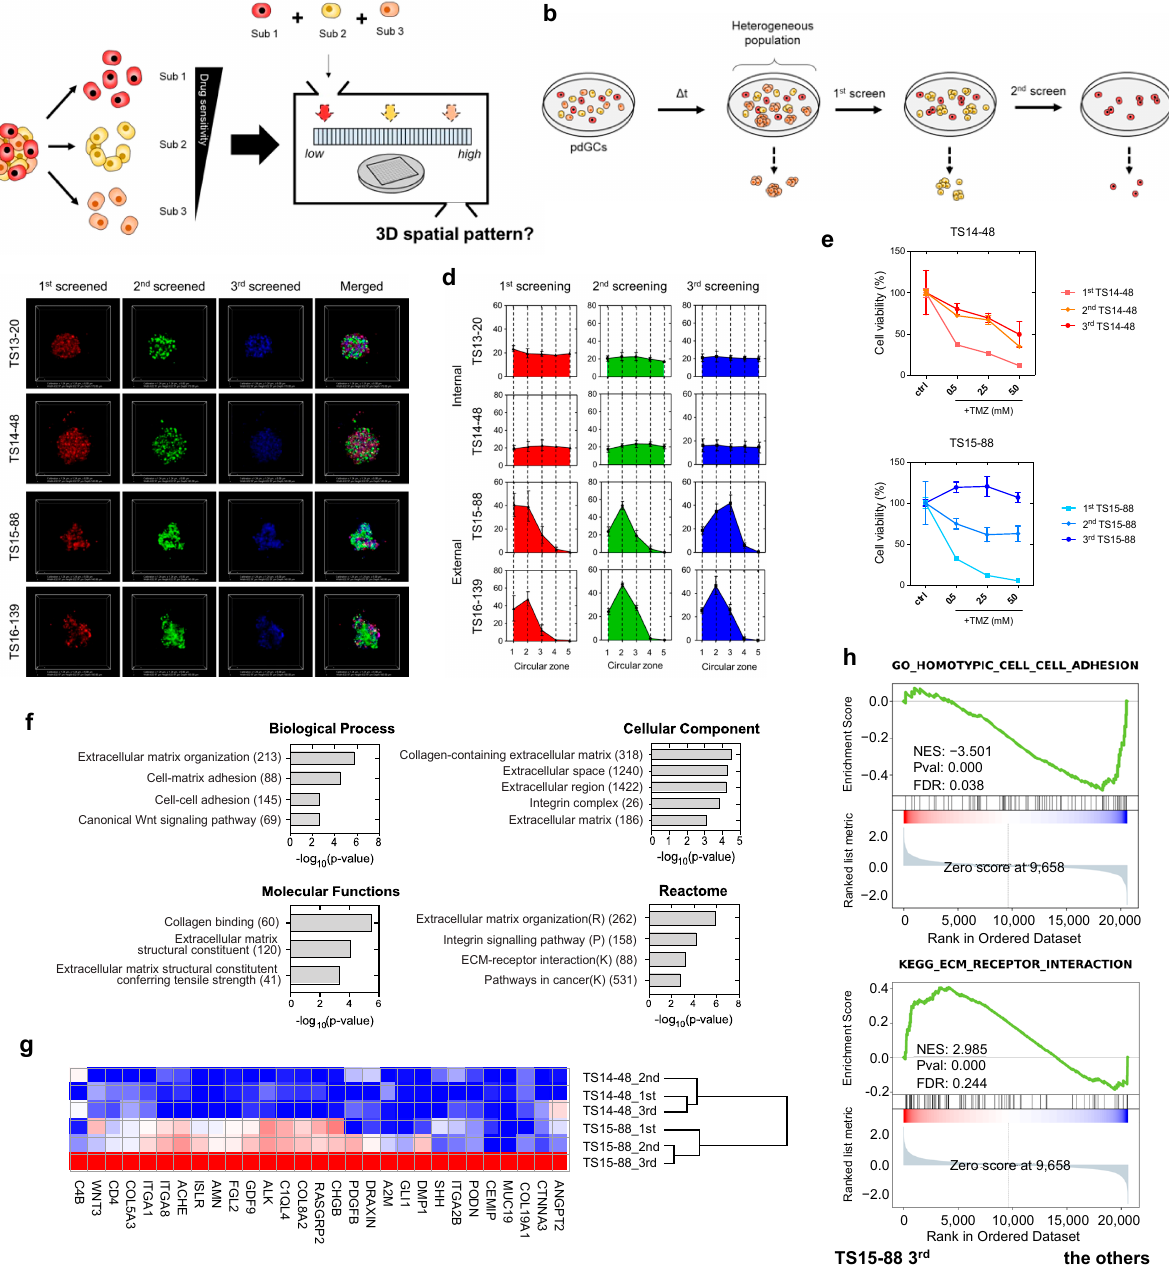
Figure 5. Multicellular self-assembly assay of intratumoral heterogeneity in drug response. ( a ) Schematic of the screening process used to identify phenotypic subpopulations within a single pdGC population. ( b ) Screening of three subpopulations from a single pdGC population. ( c ) Representative fluorescence images showing the formation of 3D spatial configurations in pdGC-only MAs. Scale bar: 200 μ m. ( d ) Spatial configurations (3D) of pdGC–U251–U87 MAs. ( e ) TS14-48 and TS15-88 cell viabilities (TMZ resistance levels); the subpopulations were those of single pdGCs (initial density 1.0 × 10 5 cells). ( f ) A bar graph showing the numbers of upregulated genes in TS15-88_3rd cells, compared to the other subpopulations (TS14-48 1st, 2nd, 3rd and TS15-88 1st, 2nd), employing Gene Ontology terms in terms of biological process, cellular components, molecular functions, and reactome. ( g ) Enriched gene expression heatmaps of sequentially screened TS14-88 and TS15-88 pdGCs. ( h ) Gene set enrichment analysis score plots for distinct phenotypes in the third-screened TS15-88 subpopulation (TS15-88_3rd), compared to the other subpopulations.